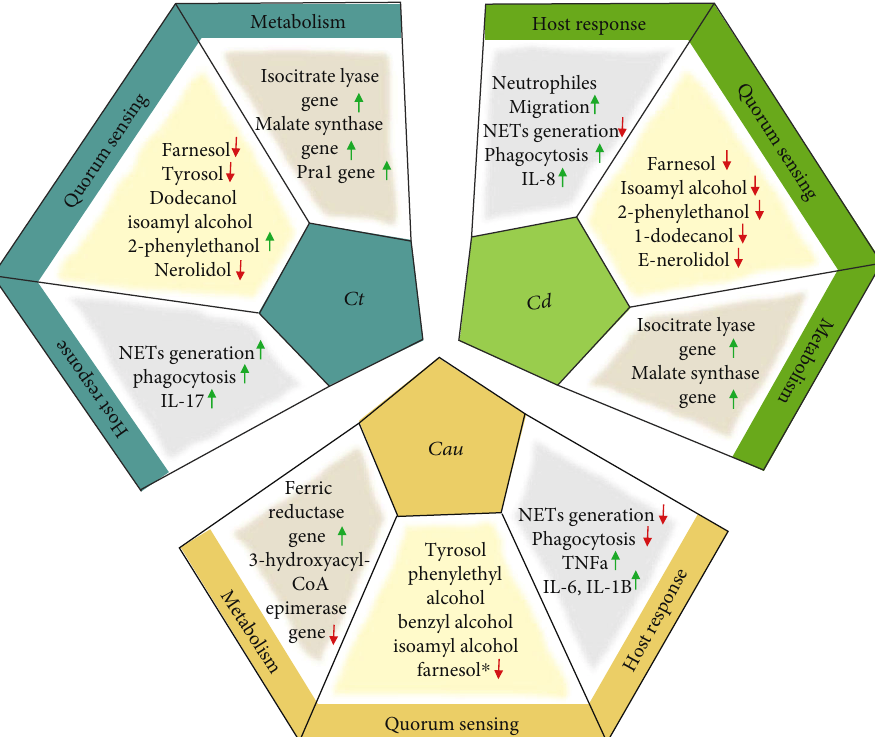
Figure 3: Selected factors of C. tropicalis ( Ct ), C. dubliniensis ( Cd ), and C. auris ( Cau ) related to their interaction with the environment and the host. The development of a fungal infection can enhance (green arrow) or inhibit (red arrow) some processes related to the host ’ s immune response, and it di ff ers depending on the species causing the candidiasis. In addition, the adaptation of the pathogen to the new environment in fl uences the increase (green arrow) or decrease in the expression of genes (red arrow) involved in its metabolism. In turn, the variable repertoire of secreted quorum sensing molecules favors or inhibits fungal fi lamentation and bio fi lm formation (green and red arrows, respectively). ∗ The use of external farnesol for